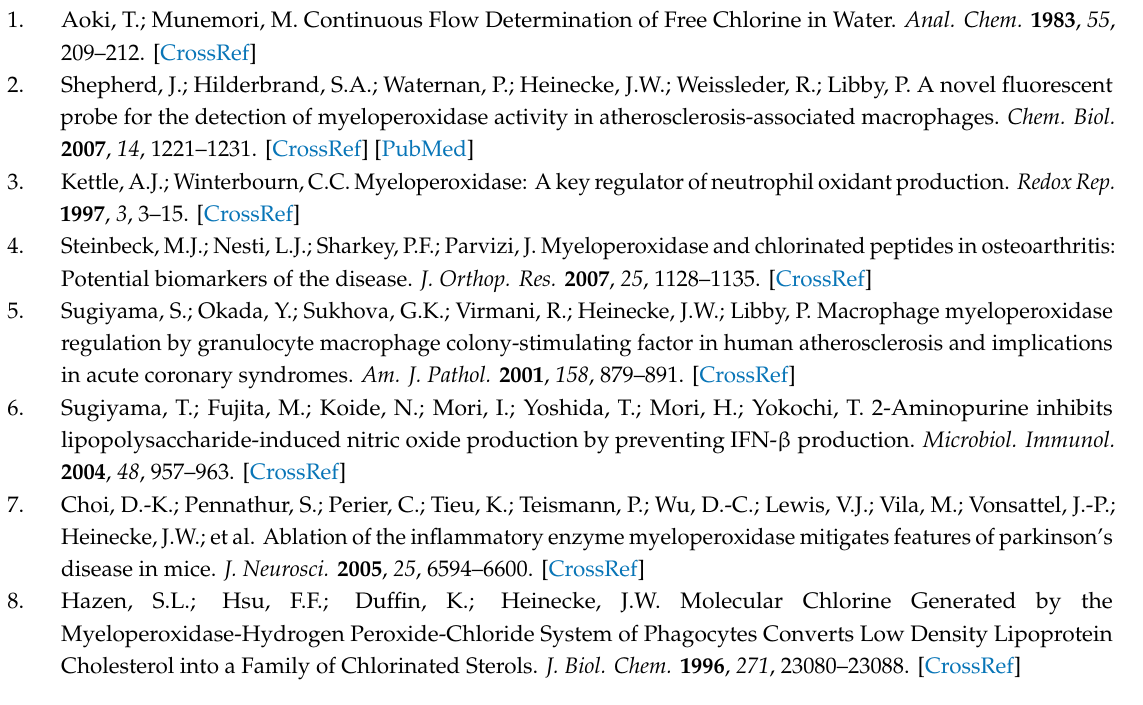
Table S1: TD-DFT calculation results. Figure S1: 1 H NMR chart of 3 . Figure S2: 13 C NMR chart of 3 . Figure S3: FAB( + )-MS chart of 3 . Figure S4: 1 H NMR chart of 1 . Figure S5: 13 C NMR chart of 1 . Figure S6: 1 H– 1 H COSY chart of 1 . Figure S7: FAB( + )-MS chart of 1 . Figure S8: TLC results. Figure S9: FAB( + )-MS chart of the product by the reaction of 1 with ClO − . Figure S10: FAB(–)-MS chart of the product by the reaction of 1 with ClO − . Cartesian Coordinates of 1 . Cartesian Coordinates of 2